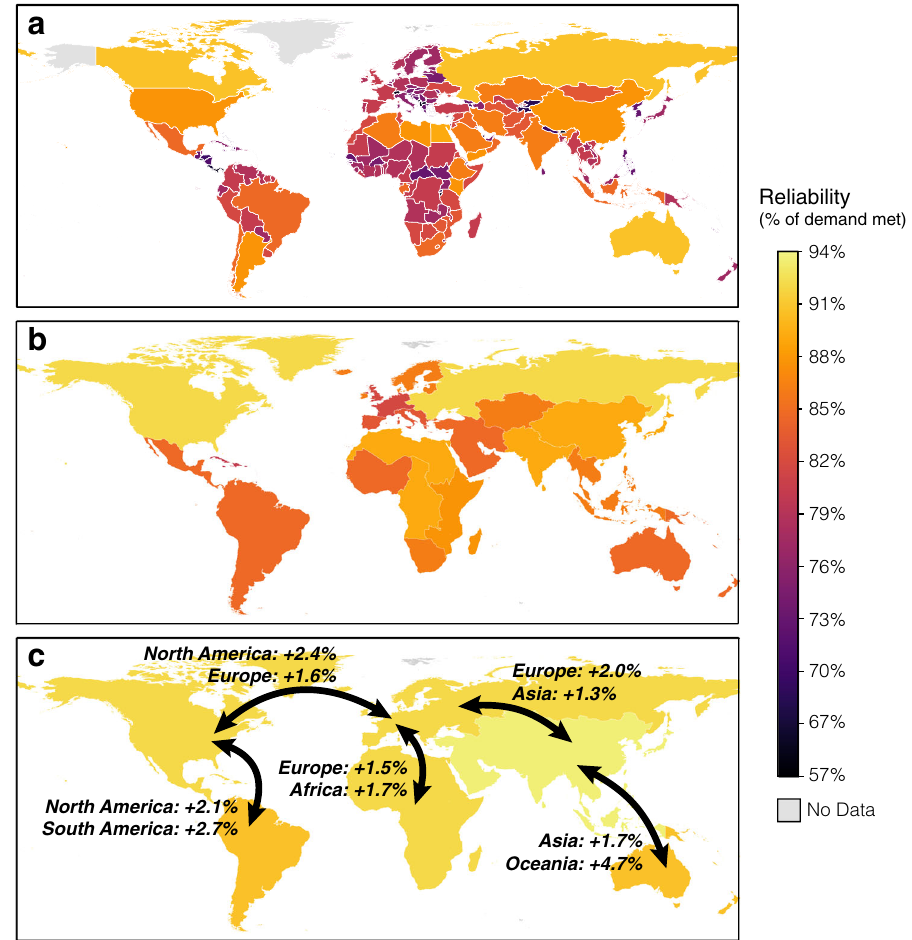
Fig. 5 Maps of electricity system reliabilities under the most reliable solar-wind mix without excess generation or energy storage. Maps show the reliability (i.e., hourly averaged resource adequacy) at country/region scale ( a ; Supplementary Data 4), the subcontinent scale ( b ; 19 multinational regions, and listed in the SI), and at continental scale ( c ; 6 continents: Asia, Europe, Africa, North America, South America, and Oceania). We also evaluated the reliability of the power supply system assuming several intercontinental connections (shown as the arrows: Asia – Oceania, Europe – Asia, Europe – Africa, North America – Europe, and North America – South America). The added reliabilities for each continental power system under various connections are